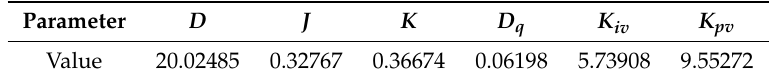
Table 3. Global optimal controller parameters.